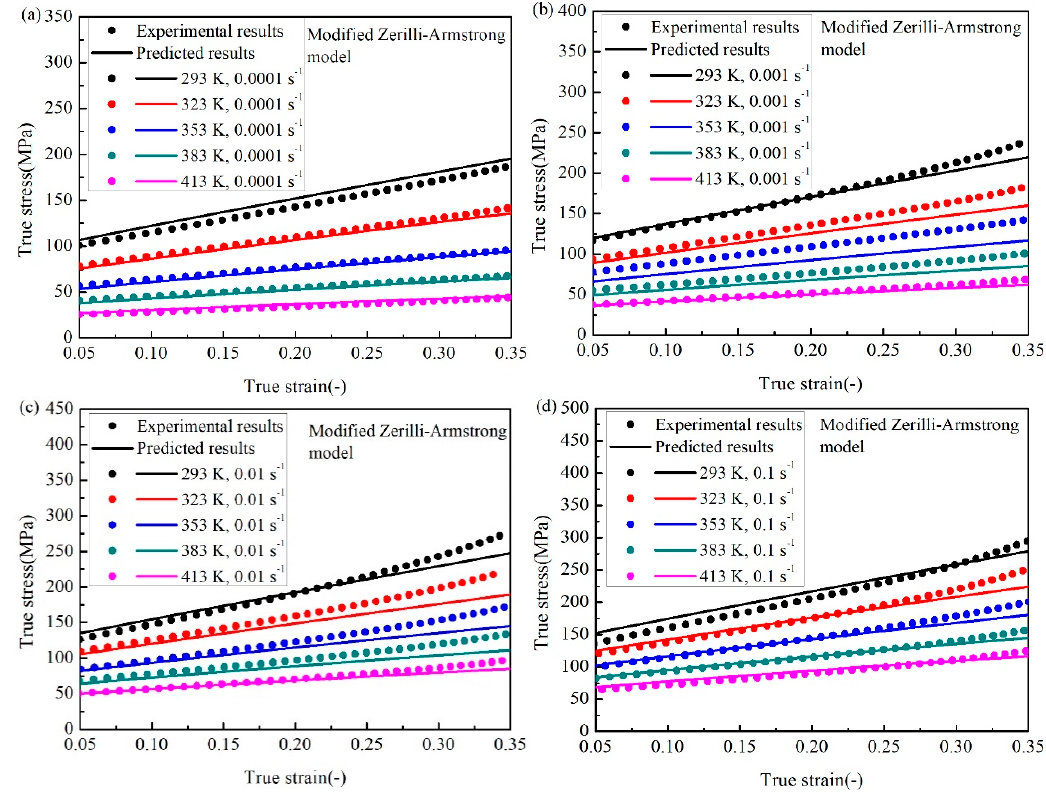
Figure 10. Scatter plot of S 2 vs. T * for different strains and the most suitable fitting line.